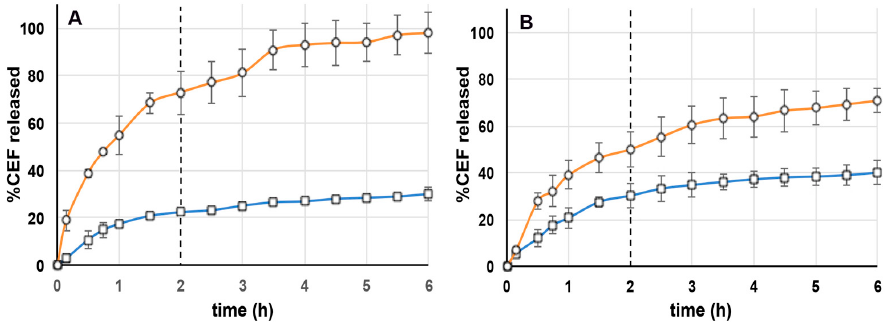
Figure 1. Release pro fi les of CEF from NLC4 DL4 ( ○ ) and CS NP DL4 ( □ ) formulations: ( A ) 2 h in SGF pH 1.2 and 4 h in SIF pH 6.8; ( B ) 2 h in SGF pH 4.5 and 4 h in SIF pH 6.8.